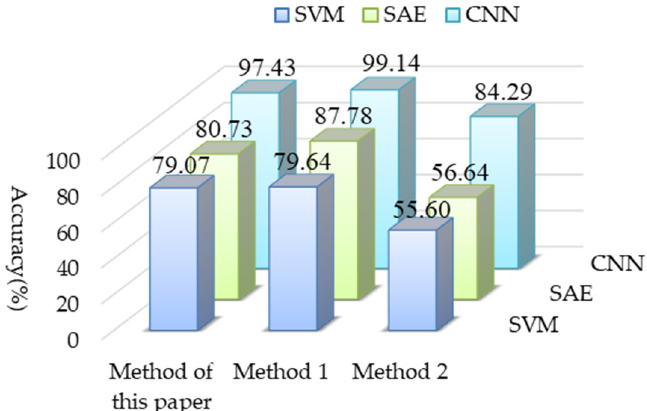
Figure 9. Diagnostic results of different